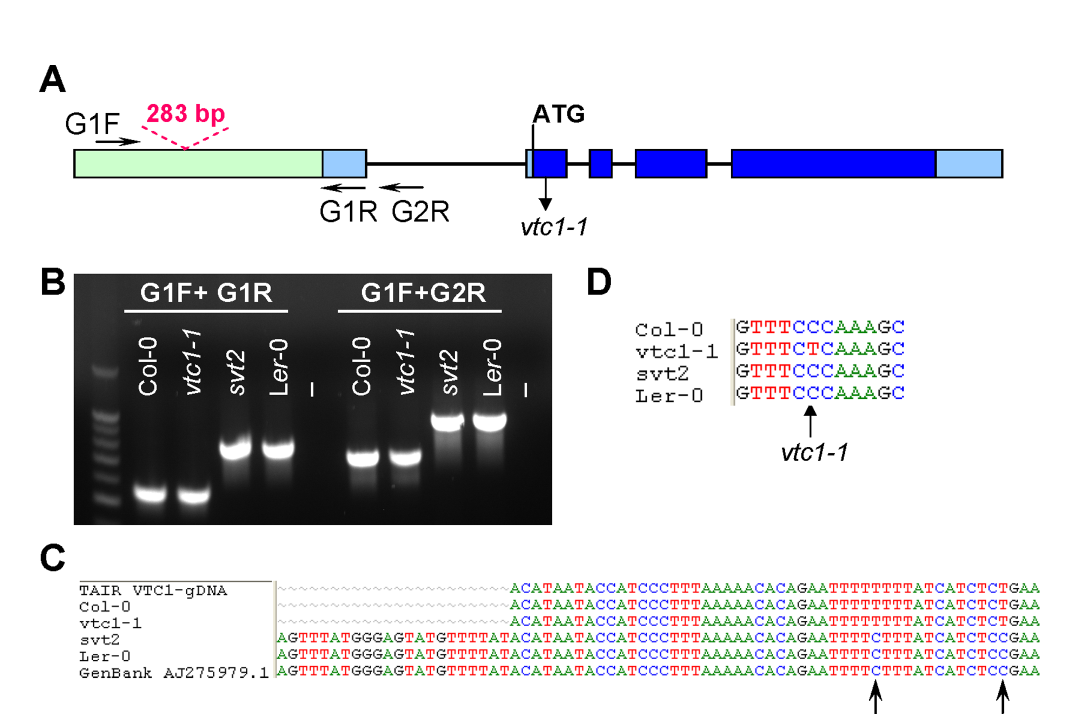
Figure 5. Genotypic characterization of svt2 . ( A ) VTC1 Col-0 gene model. Light green box indicates VTC1 gene promoter region, light blue rectangles indicate 5´ and 3´ UTRs, dark blue rectangles indicate exons, and lines indicate introns. Shown is the location of the vtc1-1 mutation within the first exon, primer locations, and polymorphism insertion of 283 bp in L er -0 VTC1 . ( B ) PCR amplification of the VTC1 promoter region in the Col-0 wild type, vtc1-1 and svt2 mutants and L er -0 wild type. (-) indicates negative control, no DNA. ( C ) Partial sequence alignment of the VTC1 promoter region from the TAIR database (Col-0), sequenced Col-0 wild type, vtc1-1 and svt2 mutants, sequenced L er -0 wild type and the L er -0 sequence obtained from GenBank. The alignment shows the sequence insertion in the svt2 mutant, the L er -0 wild type and the GenBank sequence. Arrows indicate single nucleotide polymorphisms between the L er -0 and Col-0 sequence. ( D ) Point mutation in vtc1-1 , a conversion from a cytosine to a thymine. 1 Data File